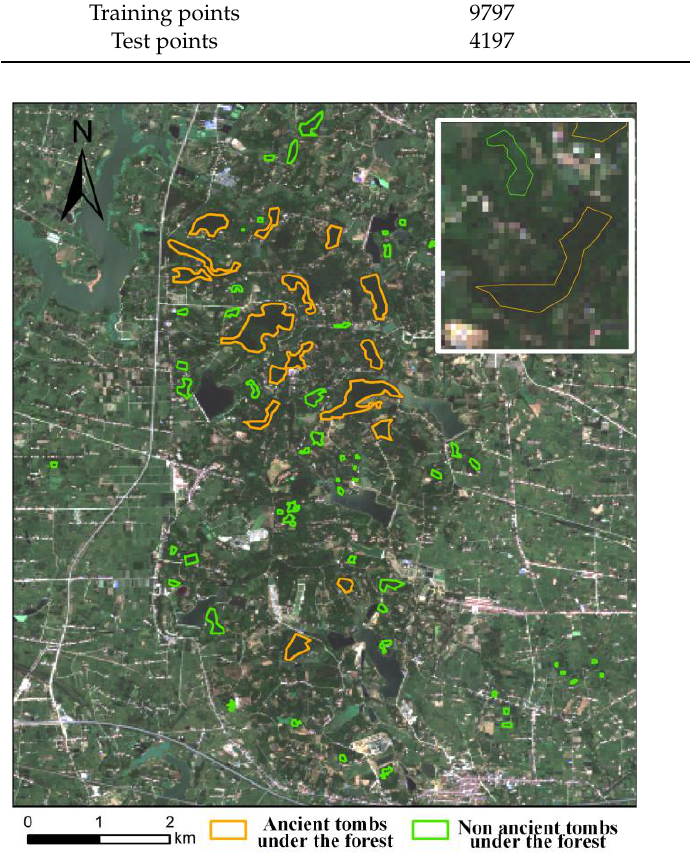
Figure 4. Sample data distribution of ancient tombs under the forest and non-ancient tombs under the forest .